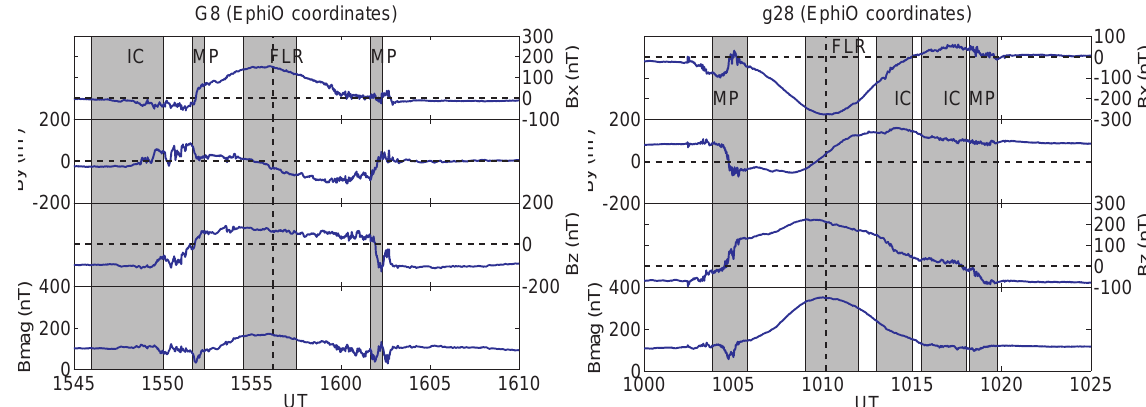
Fig. 1. Left: Galileo magnetic field data for the G8 flyby in GphiO coordinates. The GphiO coordinate system is defined as centred on Ganymede, the z-axis aligned with the rotational axis, the x-axis in the direction corotation, and the y-axis completes the triad and is mainly directed towards Jupiter. The grey filled regions are the magnetopause crossings (MP) and the intervals during which field line resonances (FLRs) and ion cyclotron (IC) waves are observed. The vertical dashed line indicates the time of closest approach. Right: the same for the G28